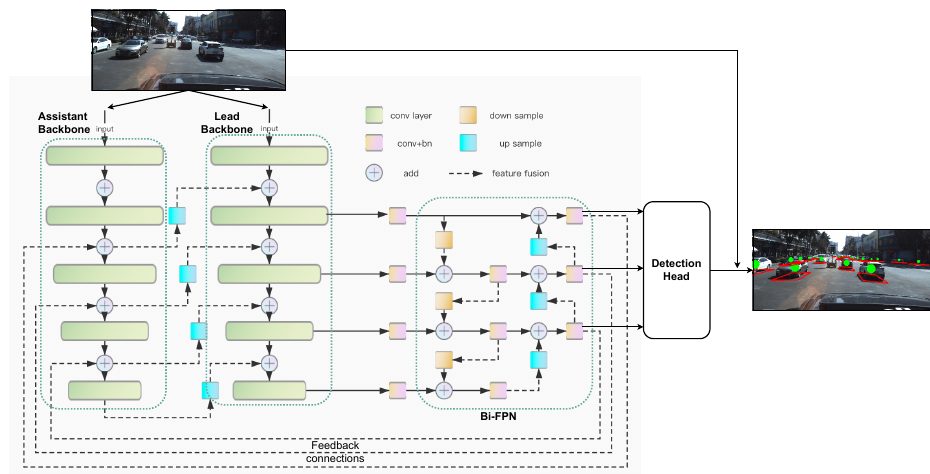
Figure 5. RCBi-CenterNet